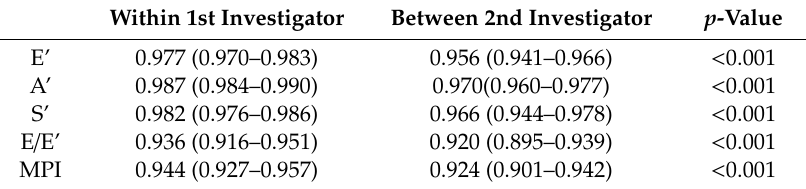
Table 4. The agreement of measured echocardiographic parameters interpreted by the intraclass correlation coefficients (ICCs).